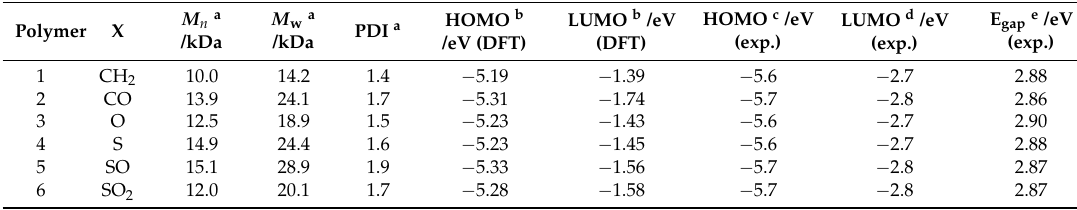
Table 1. Physical and predicted properties of novel polymers.